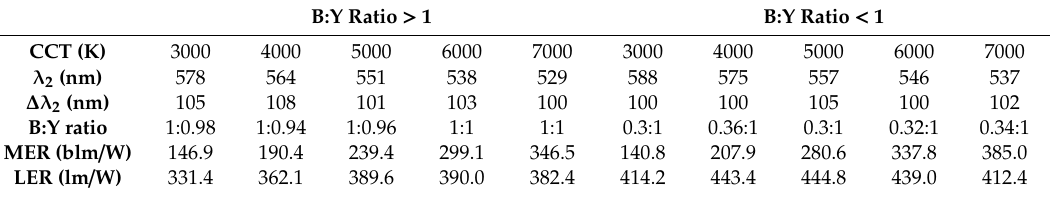
Figure 4. Spectra under different strategies: LER-maximizing strategy with ( a ) B:Y ratio > 1 and ( b ) B:Y ratio < 1. Table 1. Spectral characteristics under LER-maximizing strategy from 3000 to 7000 K.